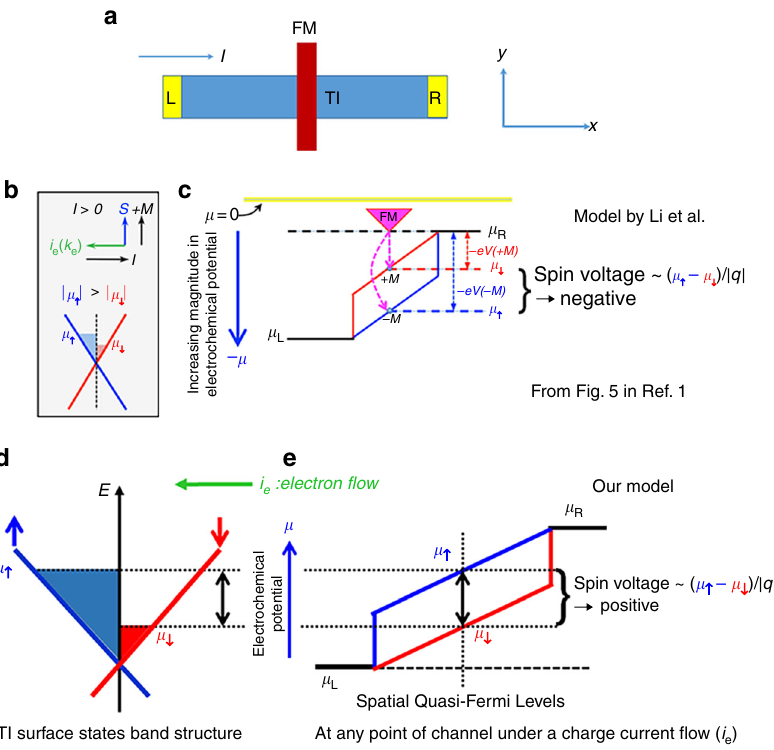
Fig. 1 Comparison of the models depicting the sign of the spin signals expected from TSS. a The schematic structure of a device with a charge current (I) fl owing from left (L) to the right (R); b The band structure diagram of TSS, taken from the left panel shared by Fig. 5b, c in ref. 1 ; c Diagram showing spatially varying spin-dependent electrochemical potential, taken from the top panel of Fig. 5c in ref. 1 . d , e Our understanding of the spin-dependent electrochemical potentials of TSS in 3D TIs under the same bias current as that shown in b , c . The chemical potential ( μ ↑ ) of up spins is higher than that ( μ ↓ ) of down spins in both d and e